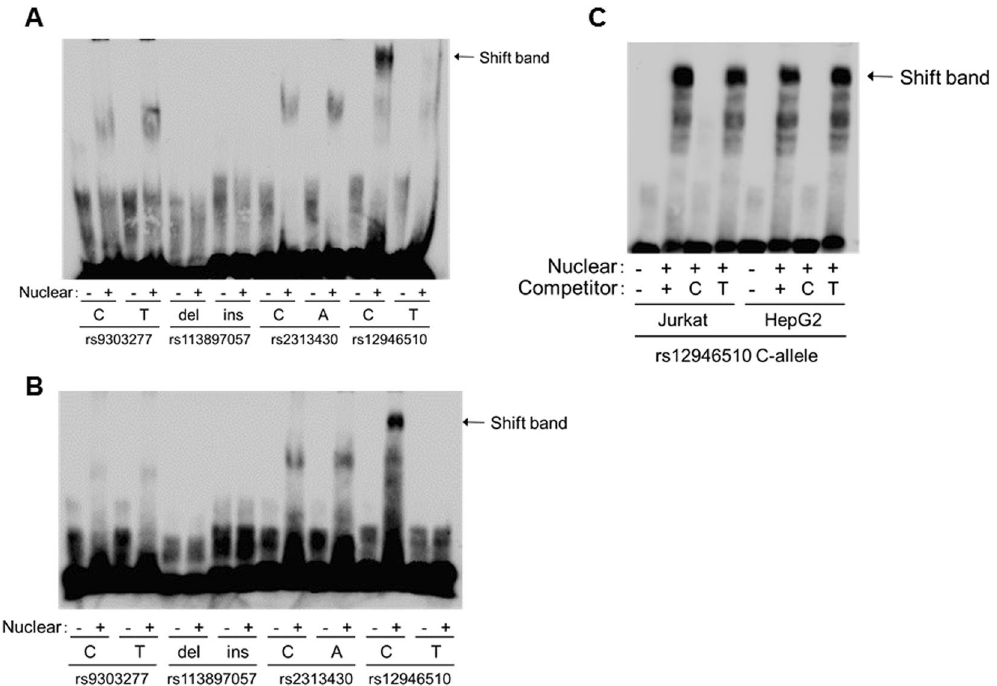
Figure 2. Analysis of each candidate functional variant using electrophoretic mobility shift assays (EMSA). ( A and B ) EMSA of each of the four candidate primary variants using biotin-labeled probes corresponding to the major alleles and the minor alleles, and nuclear extracts of Jurkat (human T lymphocyte) ( A ) and HepG2 (human liver carcinoma) ( B ) cells. Rs12946510 was the only variant to show a difference in mobility shift between the major allele (C-allele) and the PBC susceptibility allele (T-allele). ( C ) Competitor assay using a 200 × amount of unlabeled probe corresponding to the major or the minor alleles. Three independent experiments were performed in each